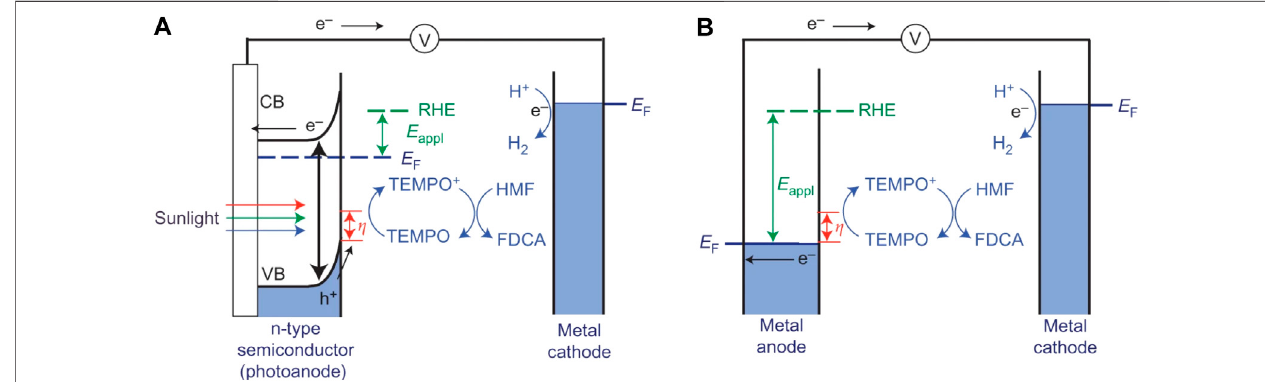
FIGURE 10 | Schematic comparison of (A) photoelectrochemical cells and (B) electrochemical cells for TEMPO-mediated HMF oxidation.